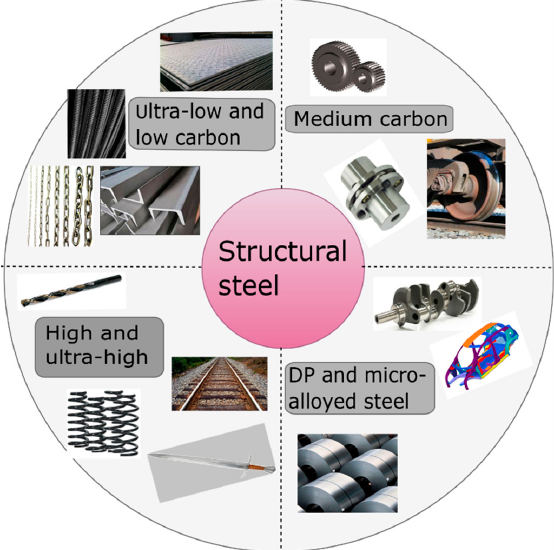
Figure 3. Schematic chart for the classification of steel.